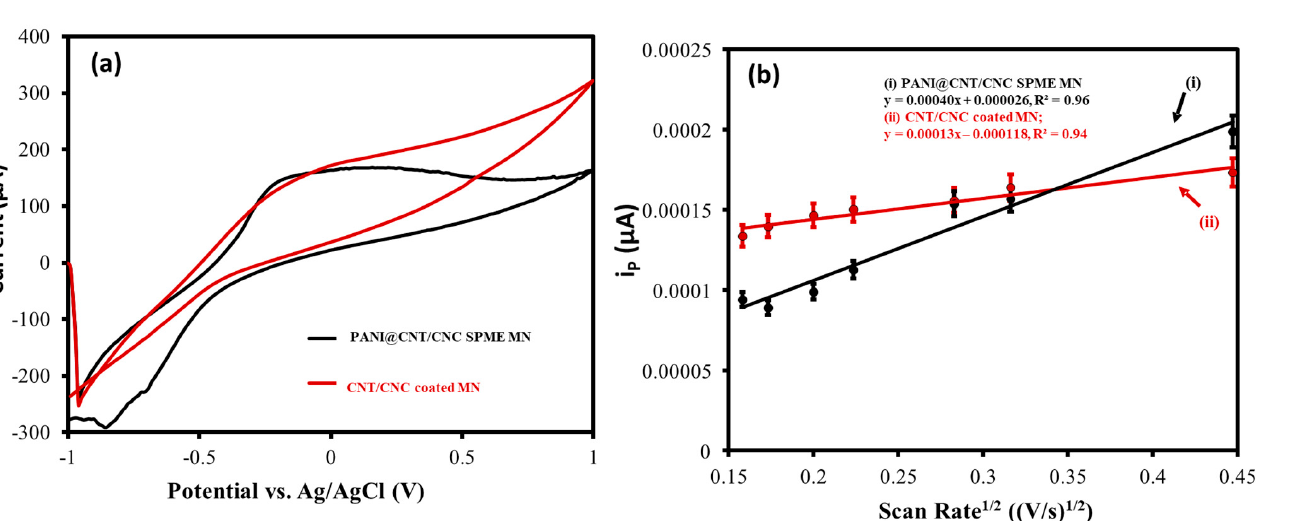
Figure 3. Overlaid Raman spectra for (i) PANI@CNT/CNC and (ii) CNT/CNC SPME MNs.